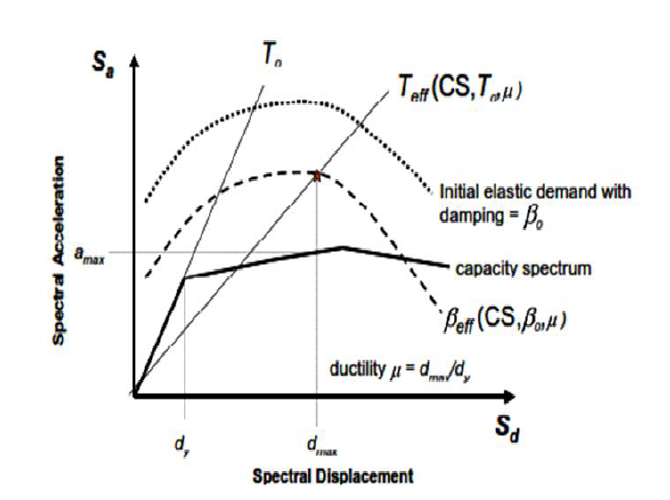
Fig. 7. Damping Values and Effective Period of the Equivalent Linear